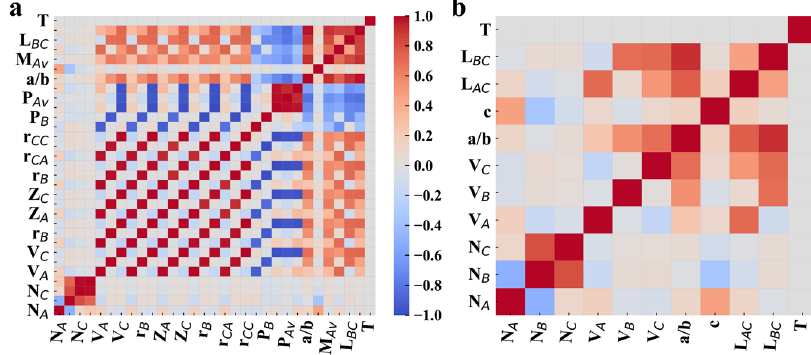
Fig. 1 Correlation coef fi cients. Correlation coef fi cients of a initial 31 descriptors and b fi nal 11